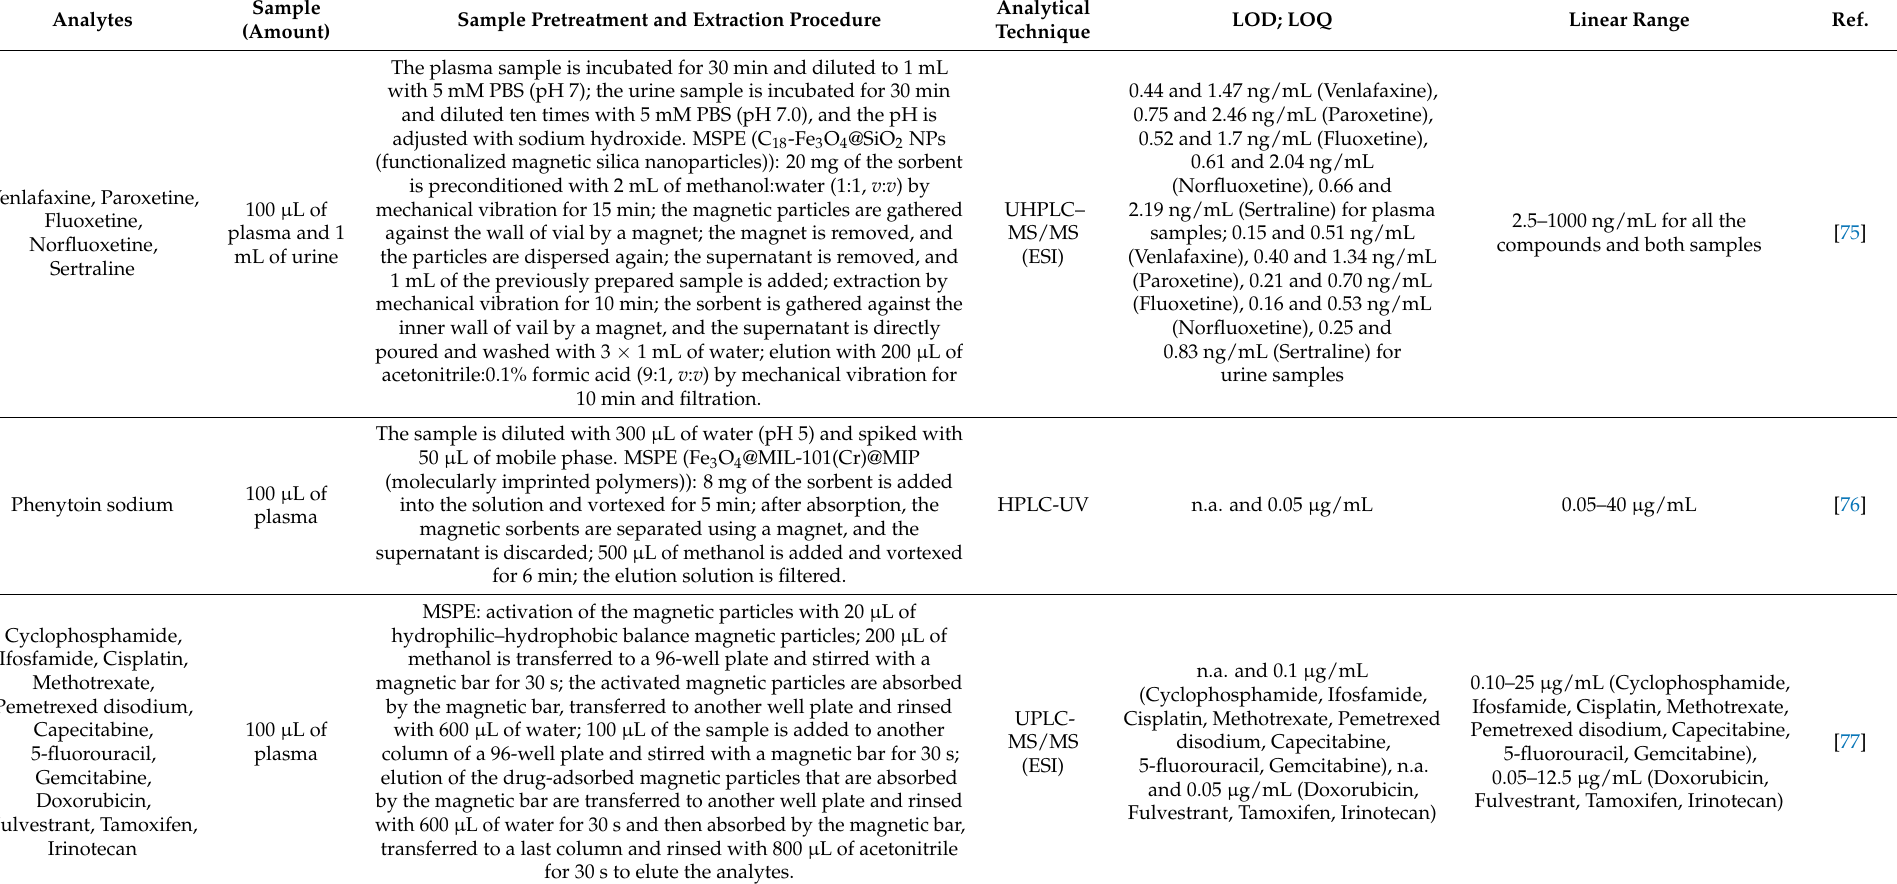
Table 7. Bioanalytical procedures using MSPE approaches for